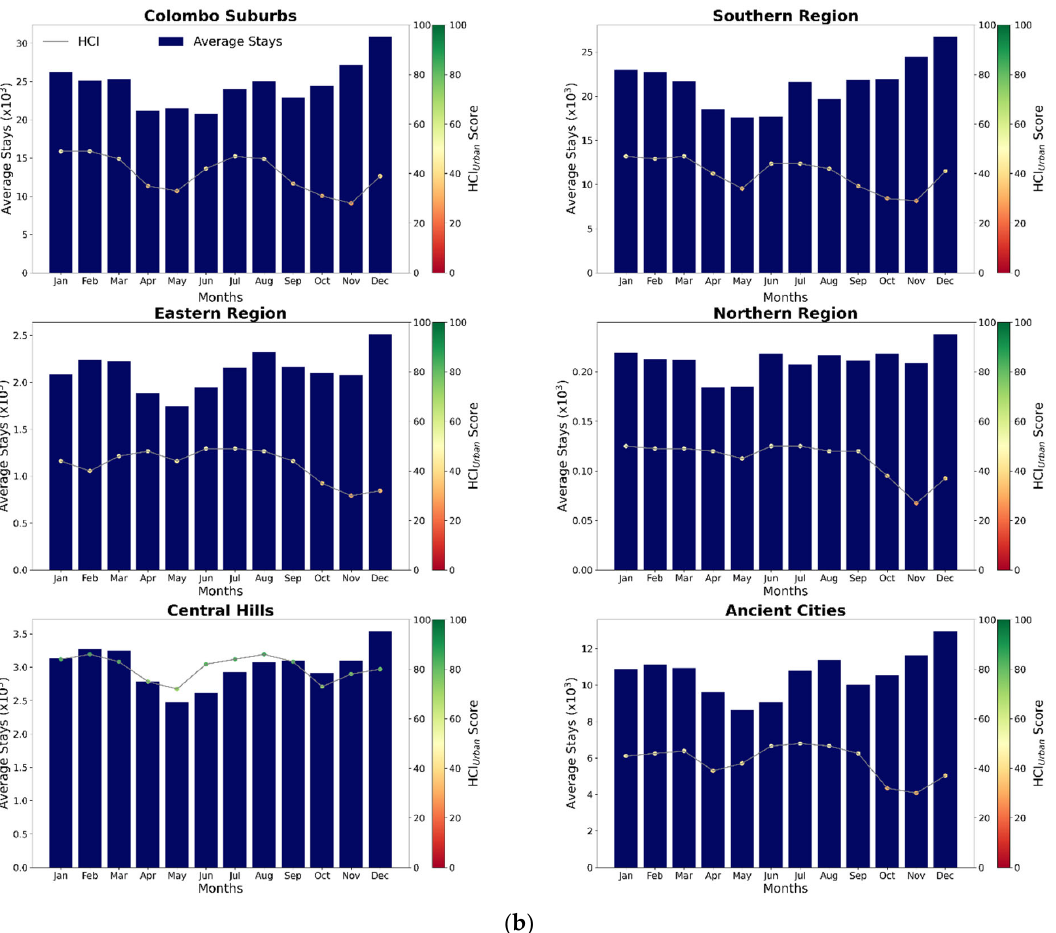
Figure 8. HCI Beach and HCI Urban score variation with average number of tourists who stayed in a particular destination (2010–2018): ( a ) For HCI Beach ; ( b ) For HCI Urban .